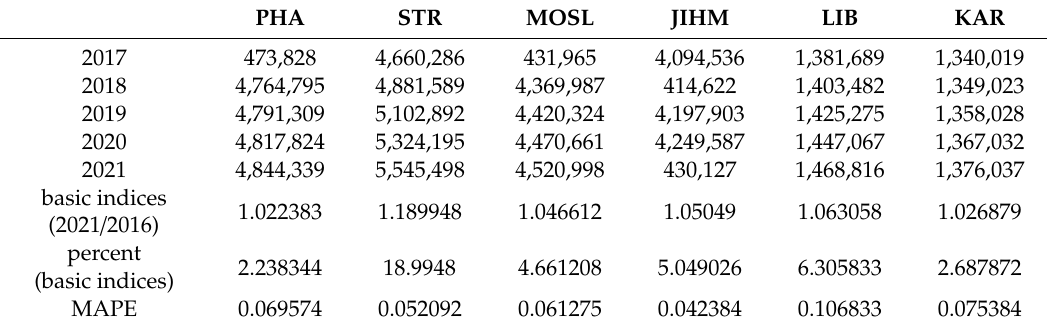
Table 1. The predicted values for the number of people employed in the Health and Social Care sector in selected regions of the Czech Republic (in thousands of people).